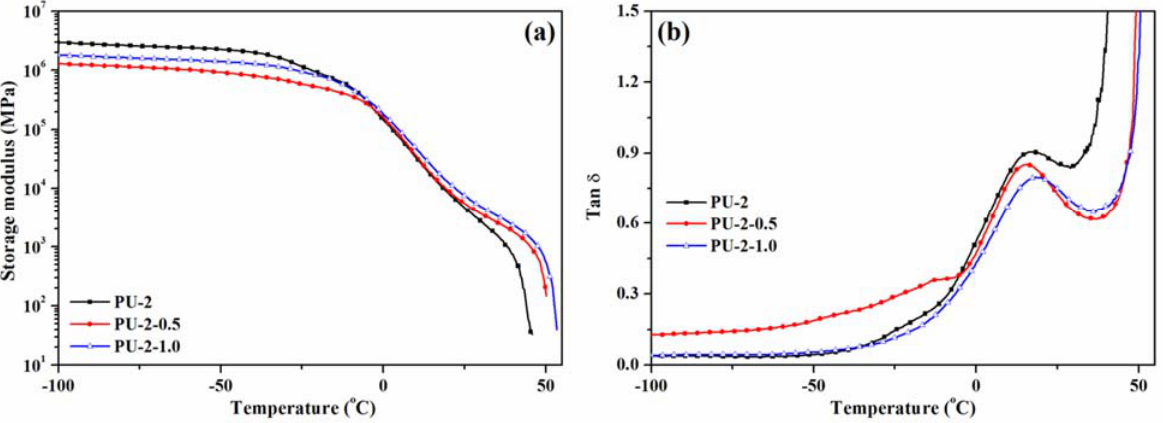
Figure 8. Storage modulus ( a ) and damping ratio ( b ) of PU-2, PU-2-0.5 and PU-2-1.0 samples as a function of temperature under a DMA loading frequency of 1 Hz.